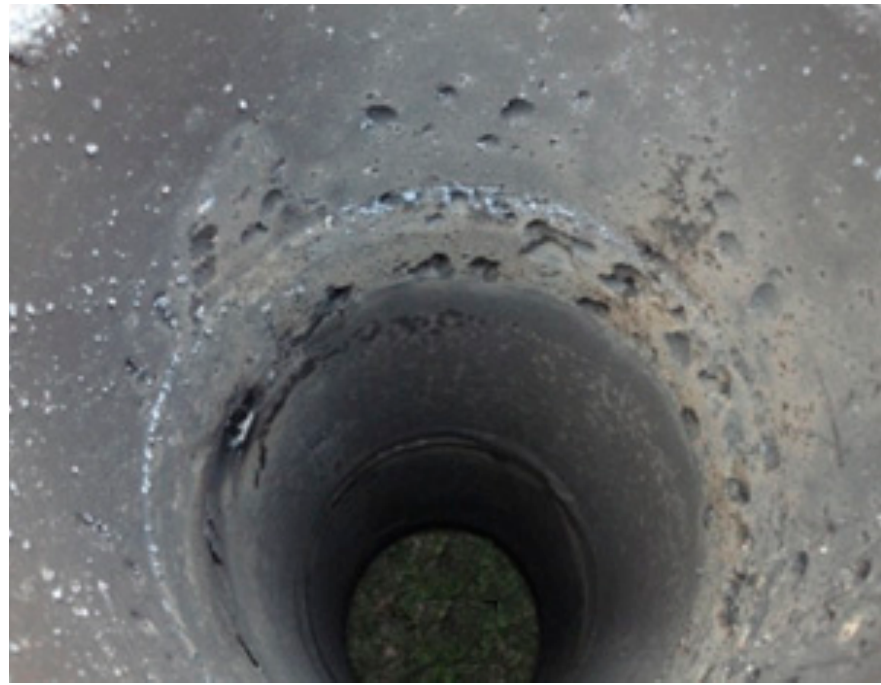
Figure 8. Internal localized corrosion defects in a pipeline that transports oilfield-produced water.